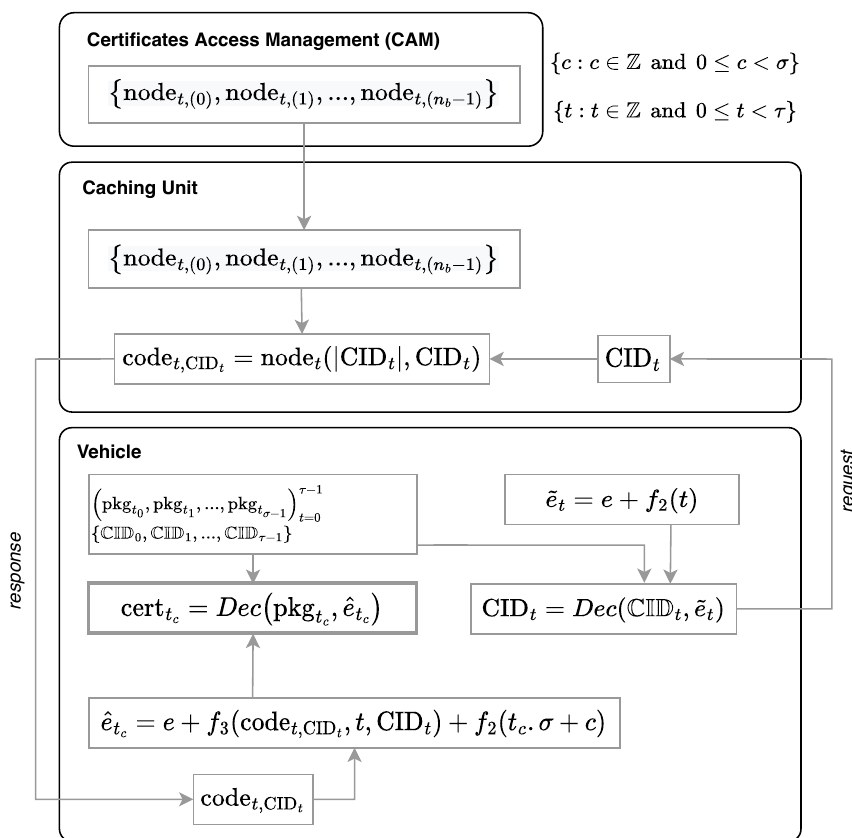
Figure 5. Certificate activation